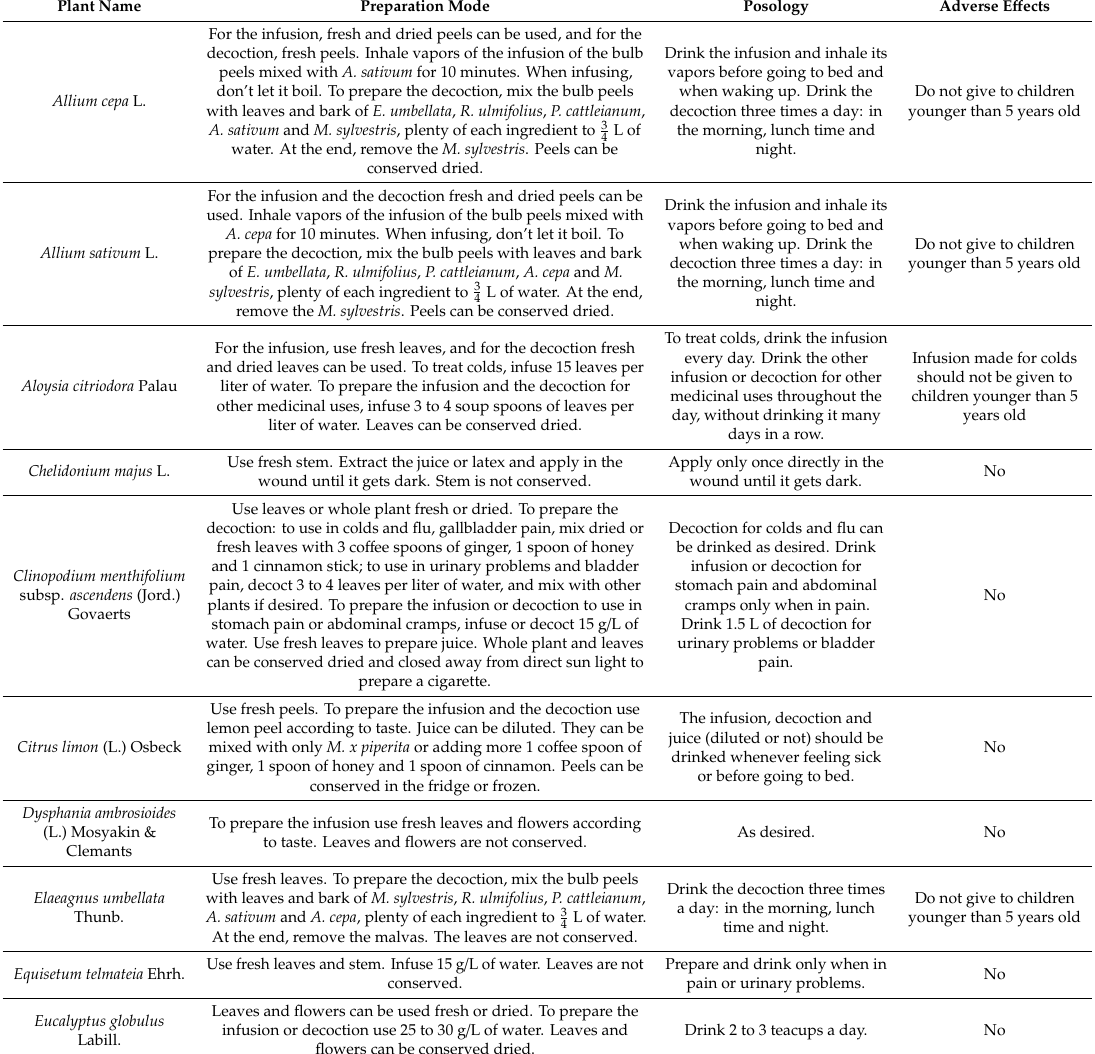
Table A1. List of di ff erent recipes and posology used by people of the Sete Cidades community in S ã o Miguel